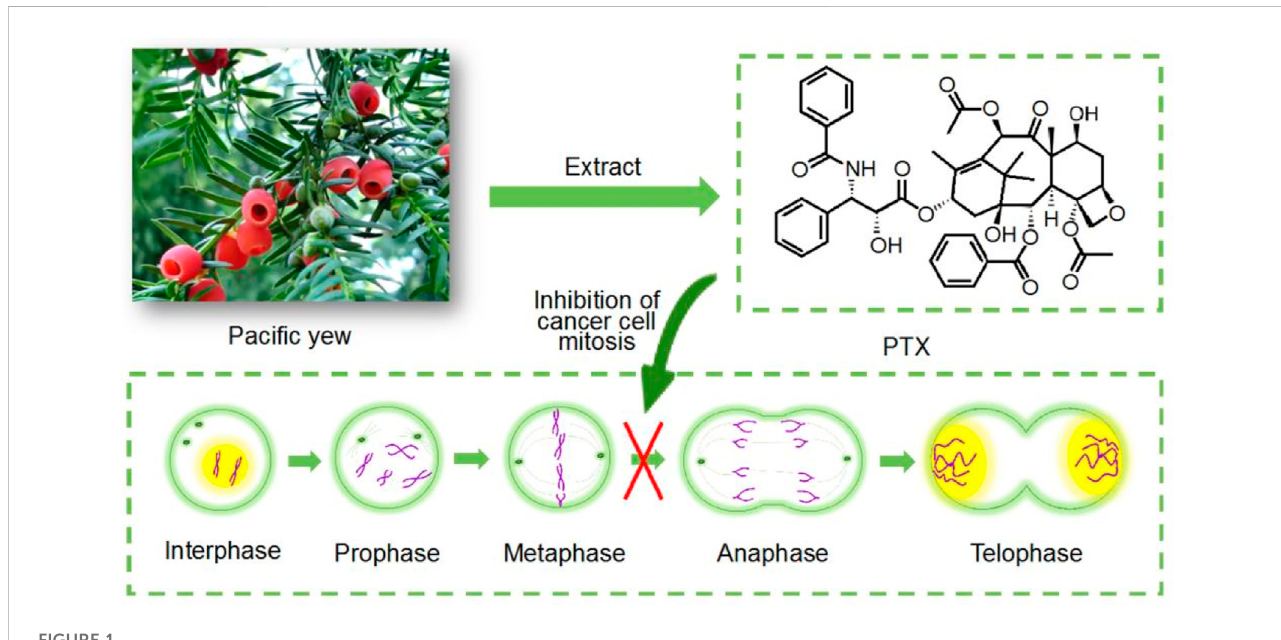
FIGURE 1 Mechanism of paclitaxel